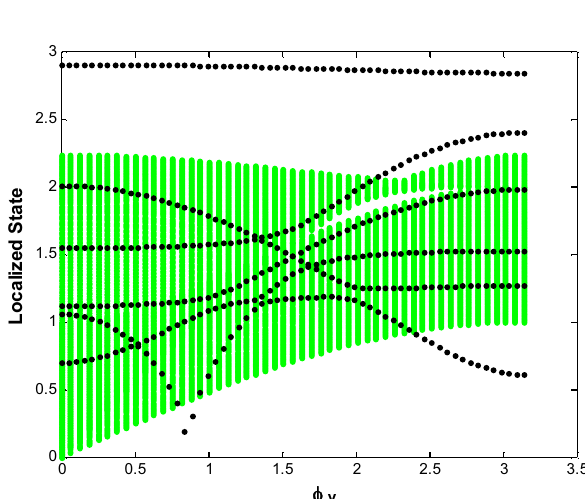
Figure 13: Branches of the localized state as function ϕ y in BZ in the softening